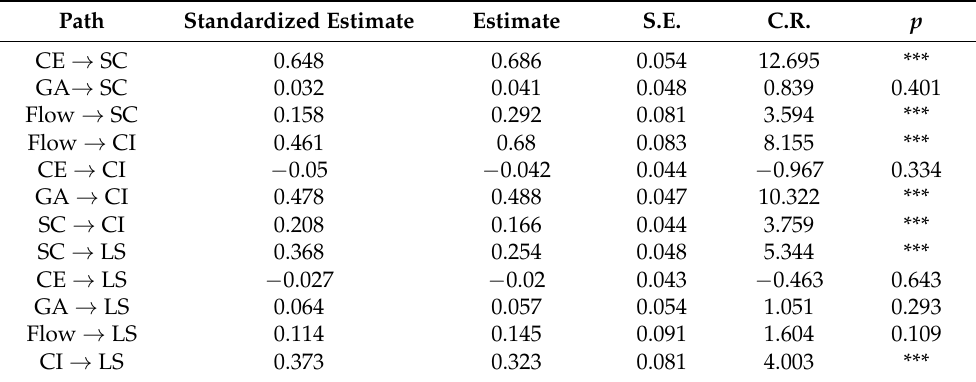
Table 7. Regression coefficients of the mediation